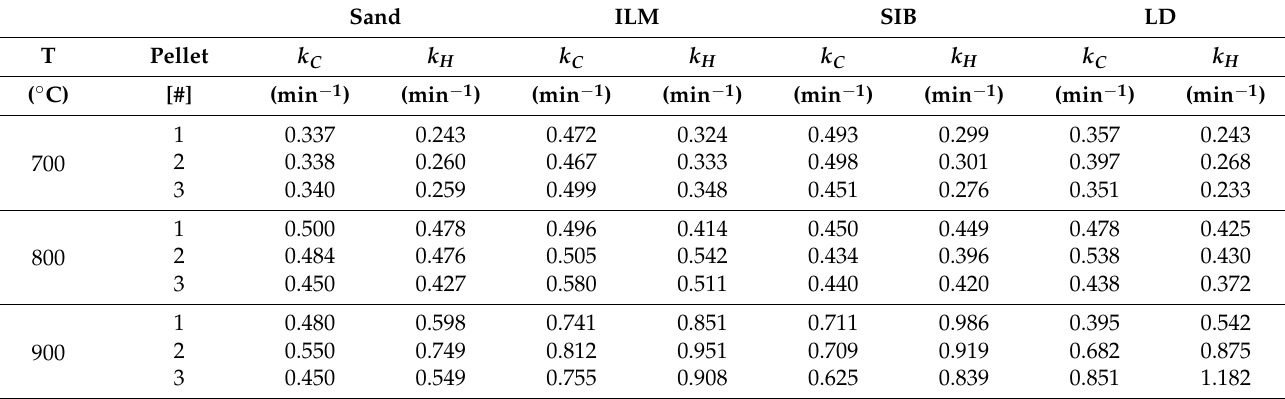
Table A4. Kinetic constants k C and k H obtained according to Section 2.4 and Appendix A for